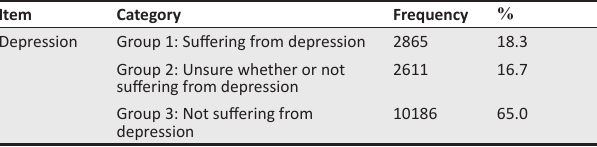
TABLE 4: Frequencies illustrating the prevalence of depression in the three depression groups.